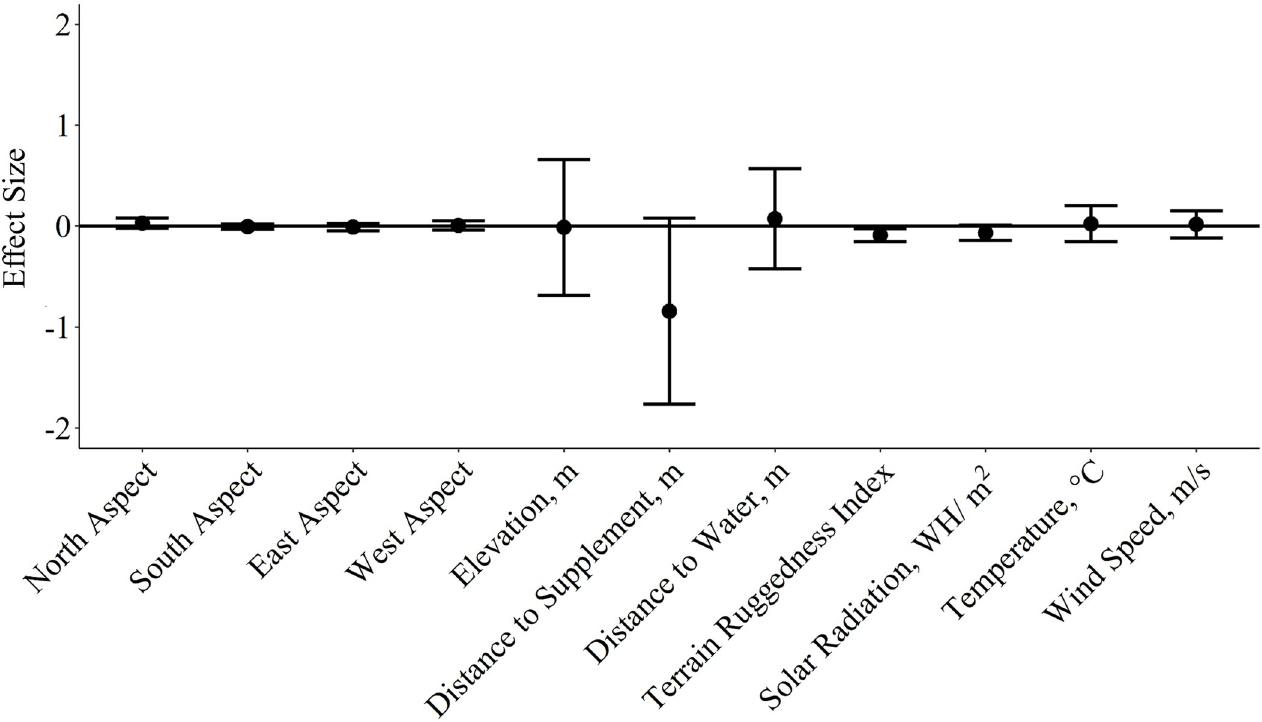
Fig 3. Mean standardized herd-level effect size ( b ^� ± 95% CI) for cattle grazing resource utilization functions, 95% confidence intervals of b ^� that do not overlap zero denote significant responses at the population level.